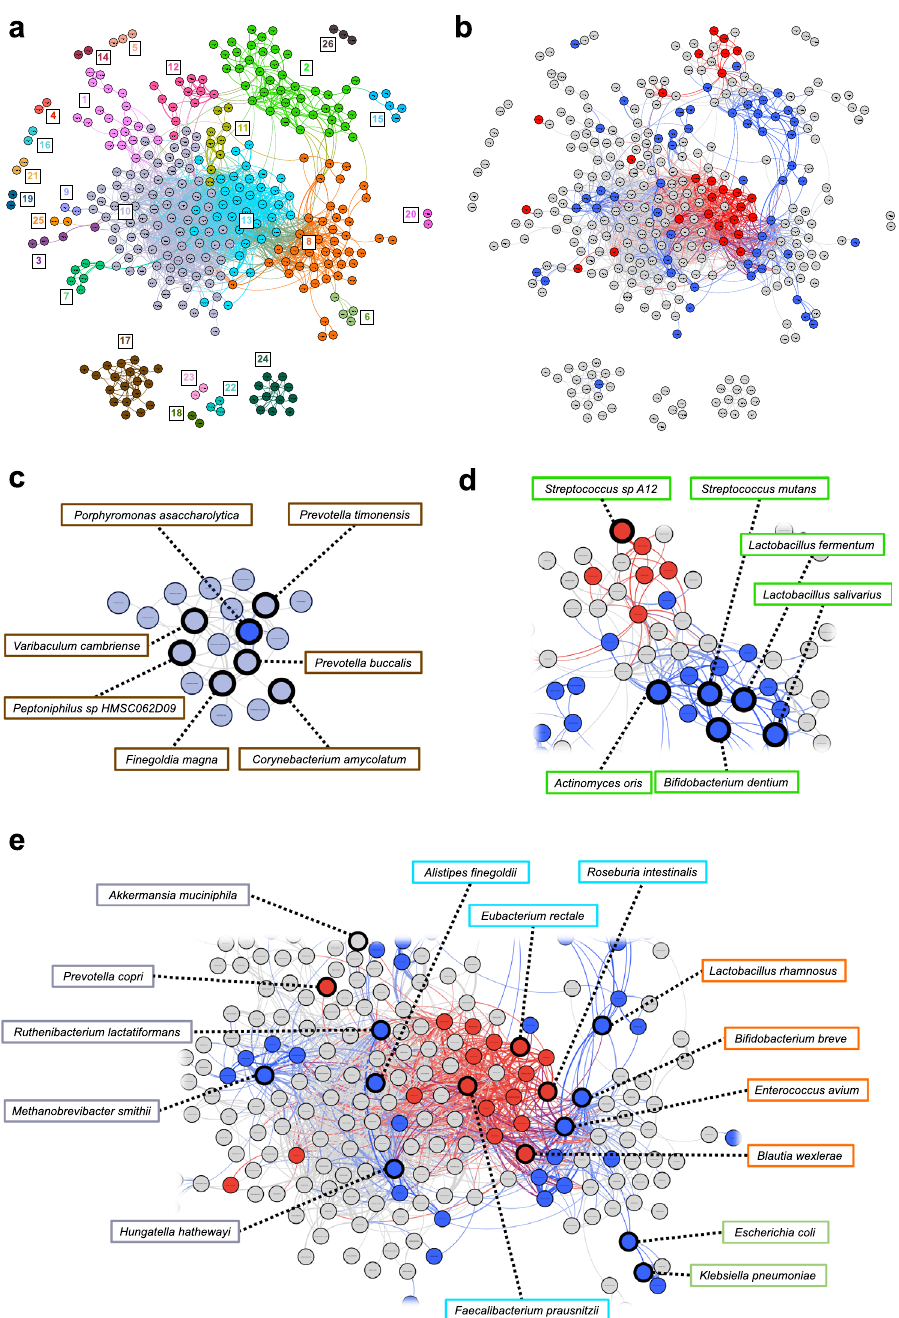
Fig.4|Networkanalysisrevealspolymicrobialclustersofcorrelatedspeciesin thePDmetagenome. Analysisincluded N =490biologicallyindependentsamples from490PDcases.(Forneurologicallyhealthycontrol(NHC)network, N =234,see SupplementaryFig.4). a AllspeciesdetectedinPDgutmetagenomeweretestedfor correlationwith one anotherusing SparCCcorrelations and plottedina networkif their abundance correlated with at least one other species (i.e., | r |>0.2 and uncorrectedpermuted P -value<0.05). Clusterswere de fi ned by Louvain algorithm and were randomly assigned a color and a number. Each circle (node) denotes a species and the curved lines (edges) connect correlated species. b PD-associated species that were identi fi ed via MWAS were mapped to the network, and high- lighted in blue if elevated in PD, or red if reduced in PD. Correlation among PD-